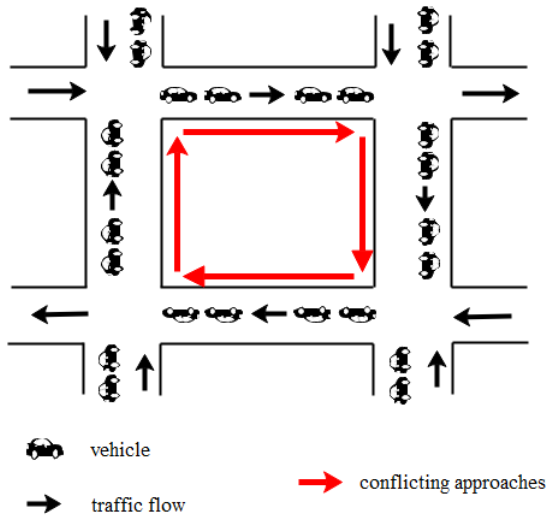
Figure 1. An example of gridlock-looped